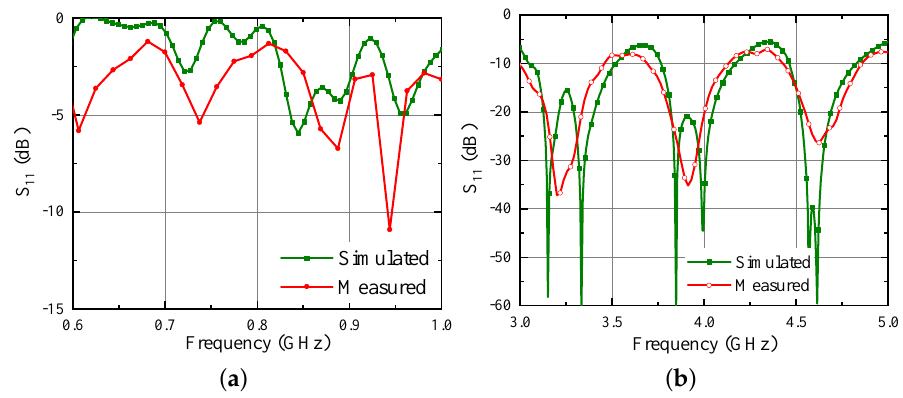
Figure 11. Simulated and measured reflection coefficient of the hybrid UWB antenna ( a ) S 11 for UHF band (normalized to 120 Ω ) ( b ) S 11 for UWB band (normalized to 120 Ω ).